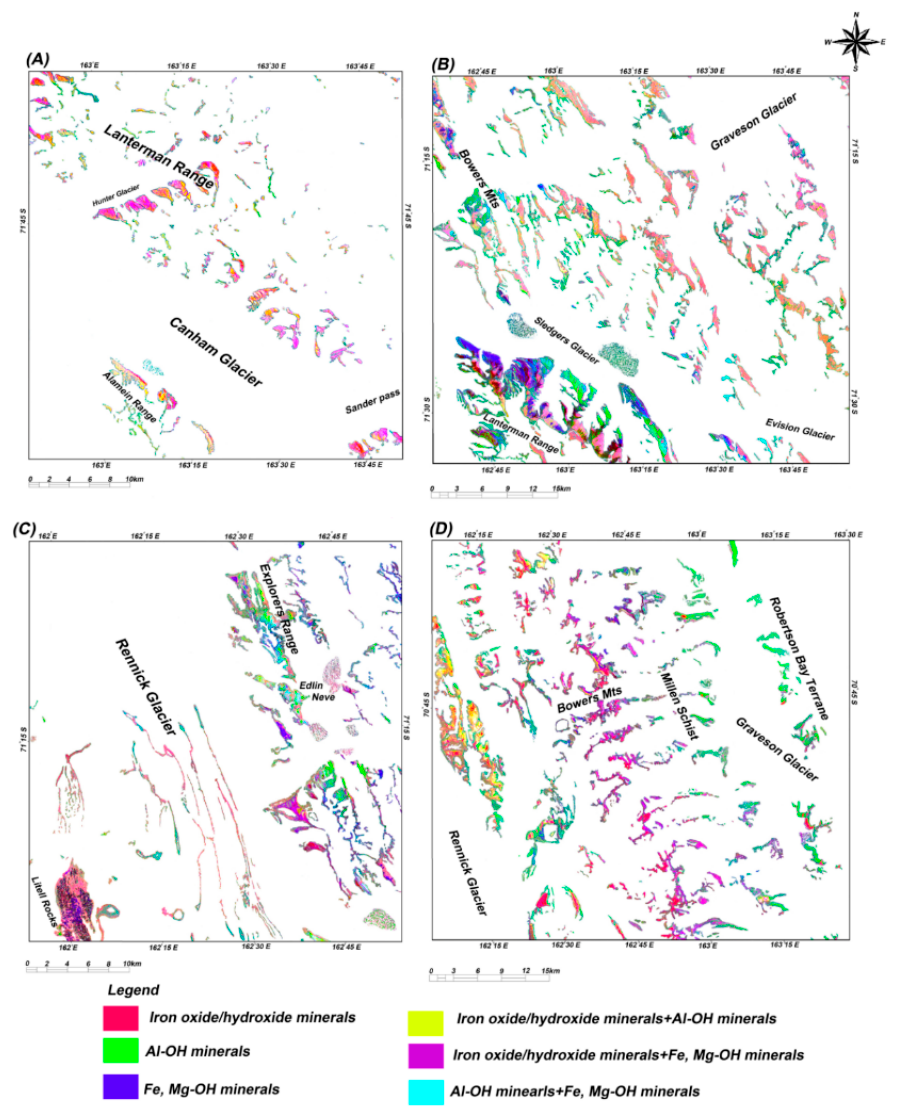
Figure 7. ASTER image maps derived from the ICA rotation and subsequent RGB color composite to VNIR + SWIR bands. ( A ) Spatial subset covering zone 1 and surrounding areas; ( B ) Spatial subset covering zones 2 and 3; ( C ) Spatial subset covering zone 4 and surrounding areas; and ( D ) Spatial subset covering zones 5 and 6.